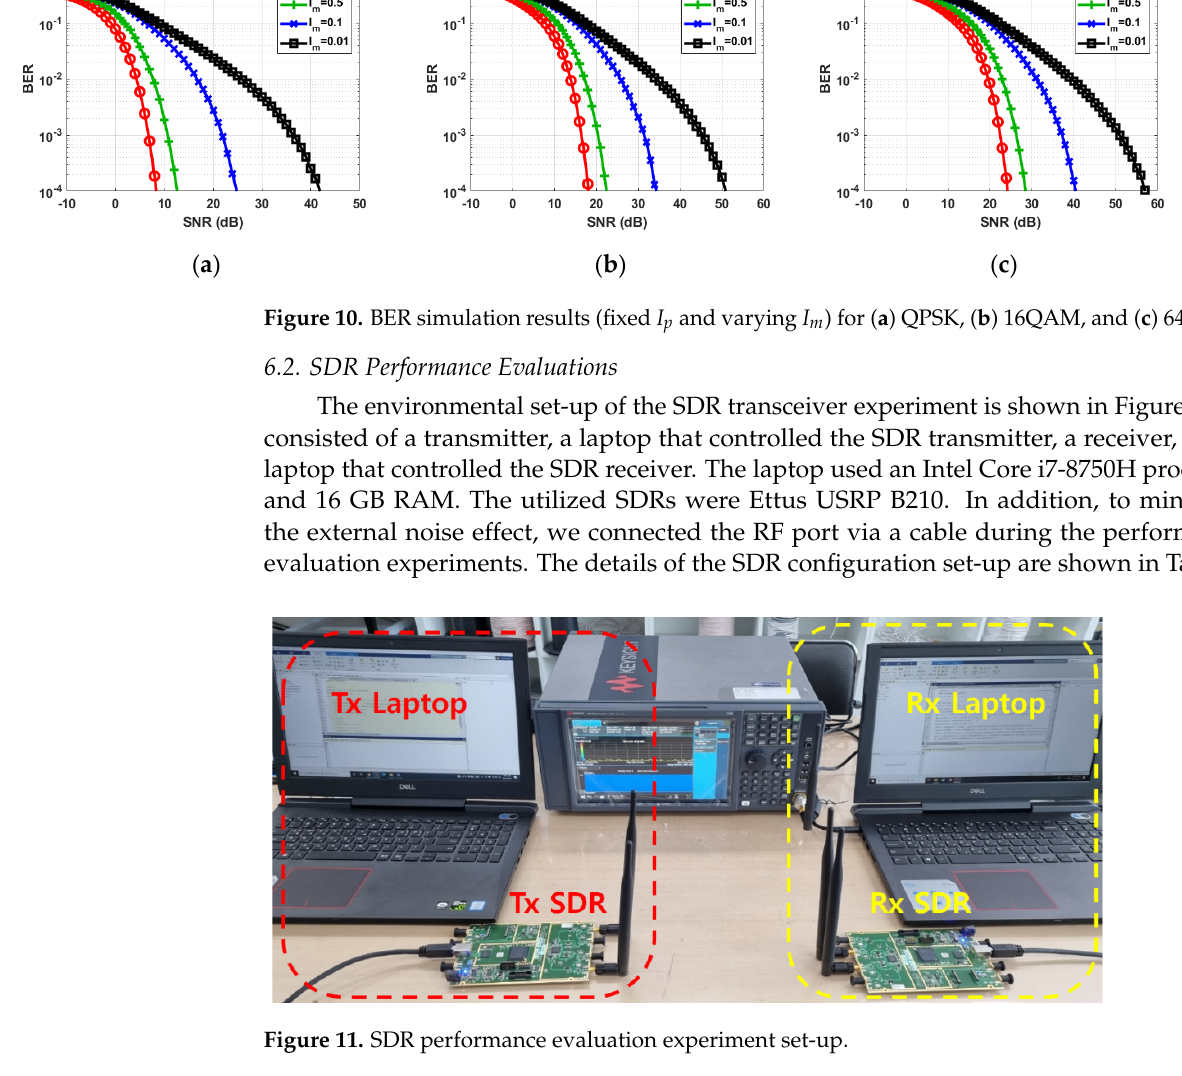
Figure 9. Constellation of ( a ) QPSK original, ( b ) 16QAM original, ( c ) 64QAM original, ( d ) reshaped